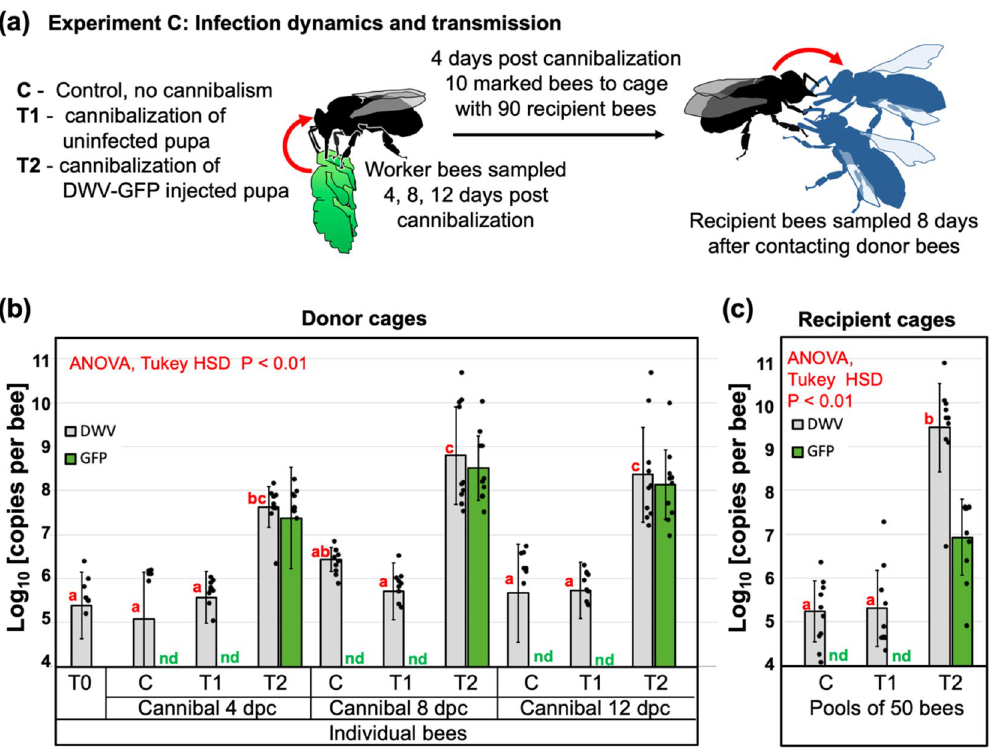
Figure 5. DWV dynamics in worker bees following cannibalization (Experiment C). ( a ) Schematic representation of the experiment. ( b ) Average DWV and GFP RNA loads in individual worker bees of the “cannibal” group, error bars indicate standard deviation. For DWV, red letters above bars indicate significantly and non-significantly different groups (ANOVA). ( c ) Average DWV and GFP RNA loads in the pools of worker bees of the recipient groups, error bars indicate standard deviation. For DWV, red letters above bars indicate significantly and non-significantly different groups (ANOVA). DWV and GFP copy number in individual pupae are indicated by black dots, nd not detectable